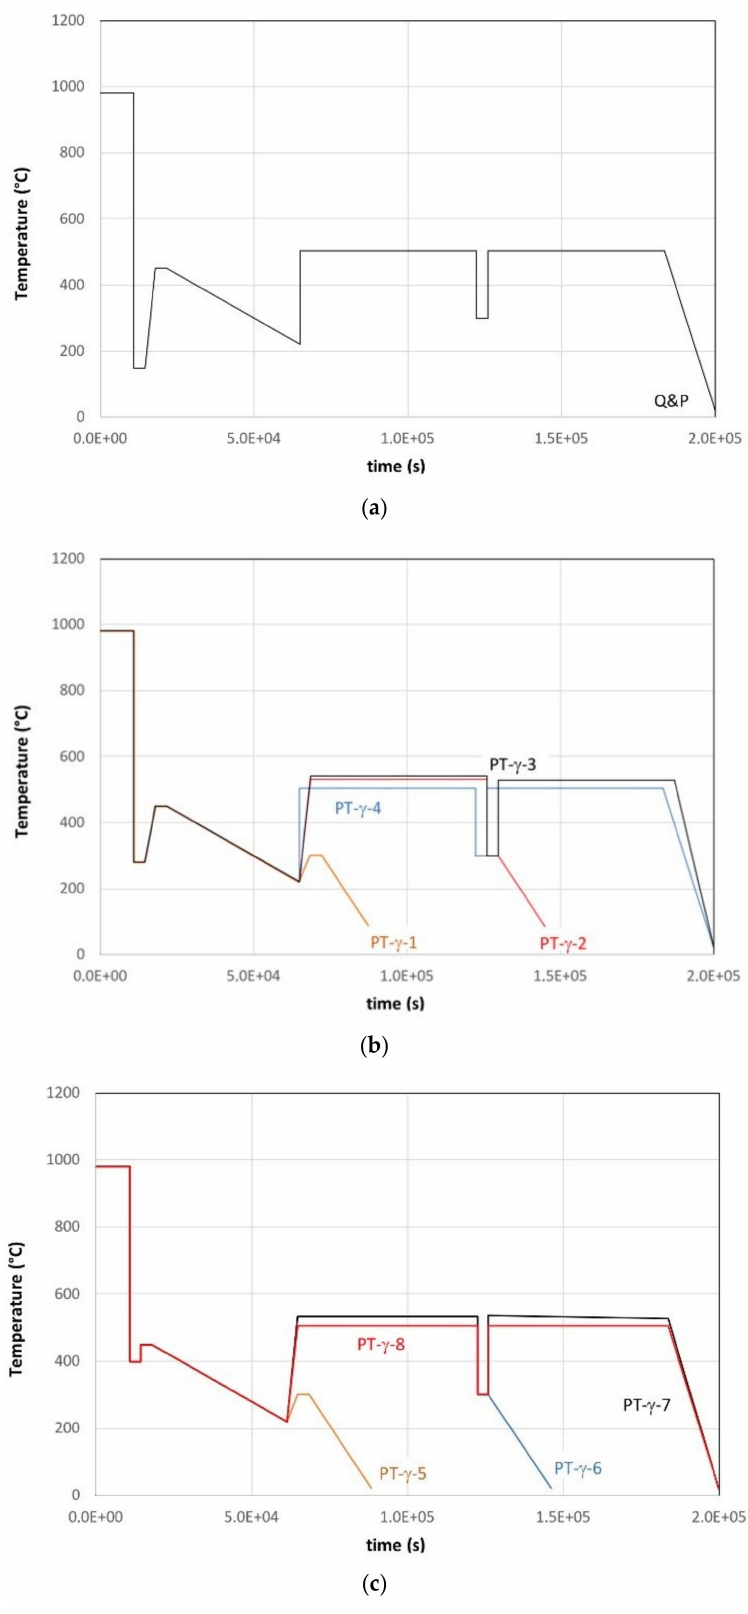
Figure 1. ( a ) Heat-treatment cycle as performed on Q & P specimen; ( b ) heat-treatment cycle as performed on specimens from PT- γ -1 to PT- γ -4; ( c ) heat-treatment cycle as performed on specimens from PT- γ -5 to PT- γ